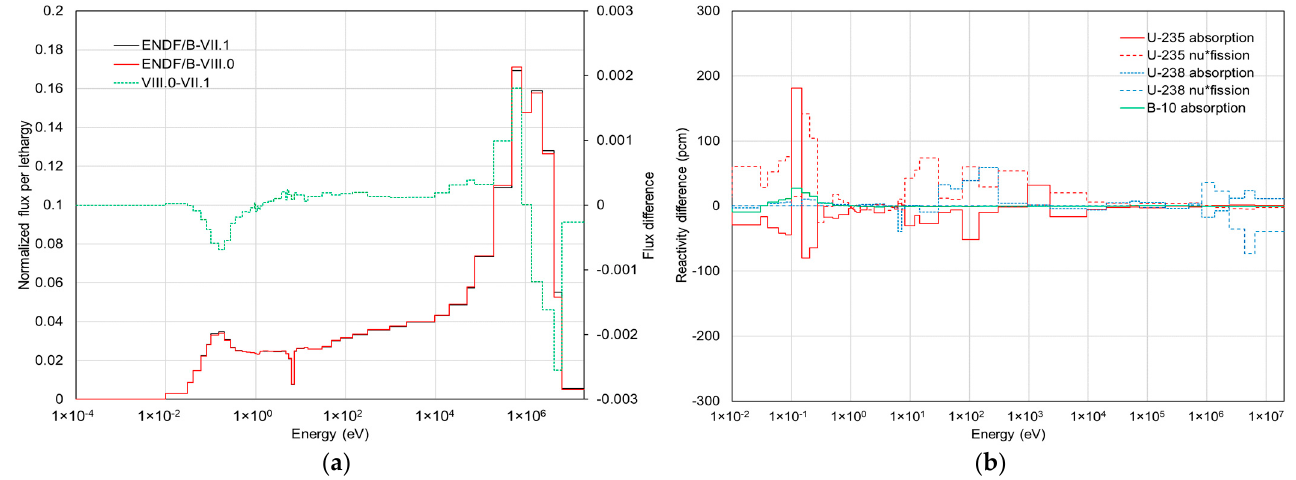
Figure 11. Comparison of the flux and reactivity for IFBA between ENDF/B-VII.1 and -VIII.0 in the 51-group structure: ( a ) neutron spectra; ( b ) reactivity differences.